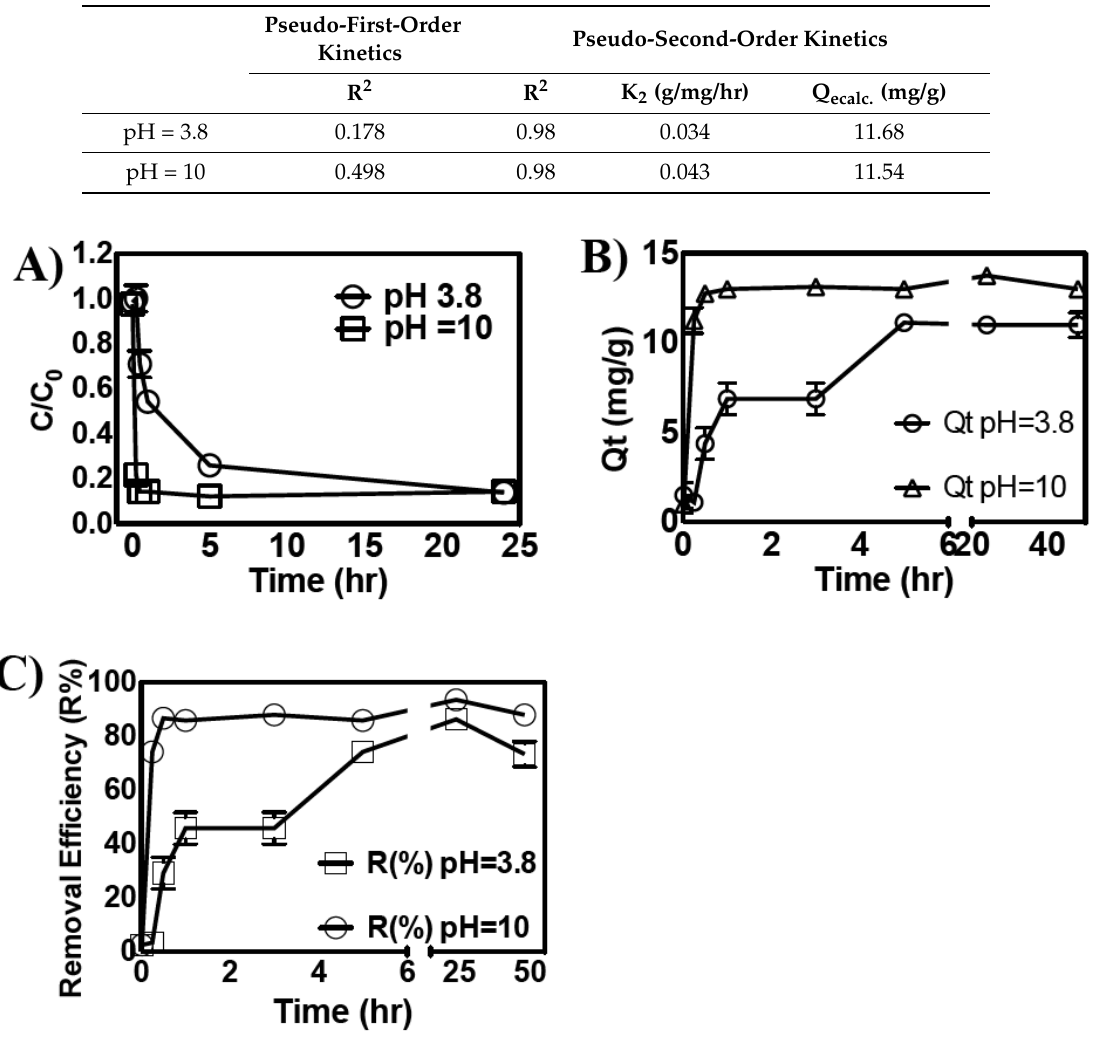
Figure 4. (A) Change in the initial concentration of iron(II) as a function of time in the presence of composite at pH 3.8 and 10; (B) effect of contact time on the iron adsorption capacity of the composite at pH 3.8 and 10; and (C) iron removal efficiency of the composite as a function of time at pH 3.8 and